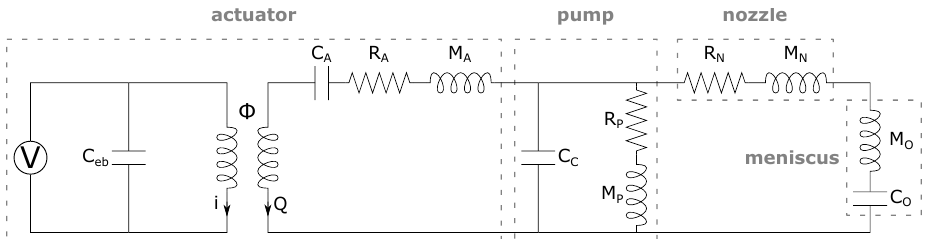
Figure 3. Equivalent circuit model of inkjet actuator and